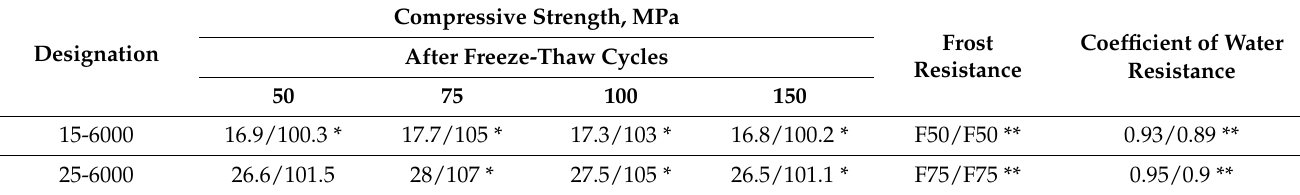
Table 8. Durability characteristics of lightweight concrete.